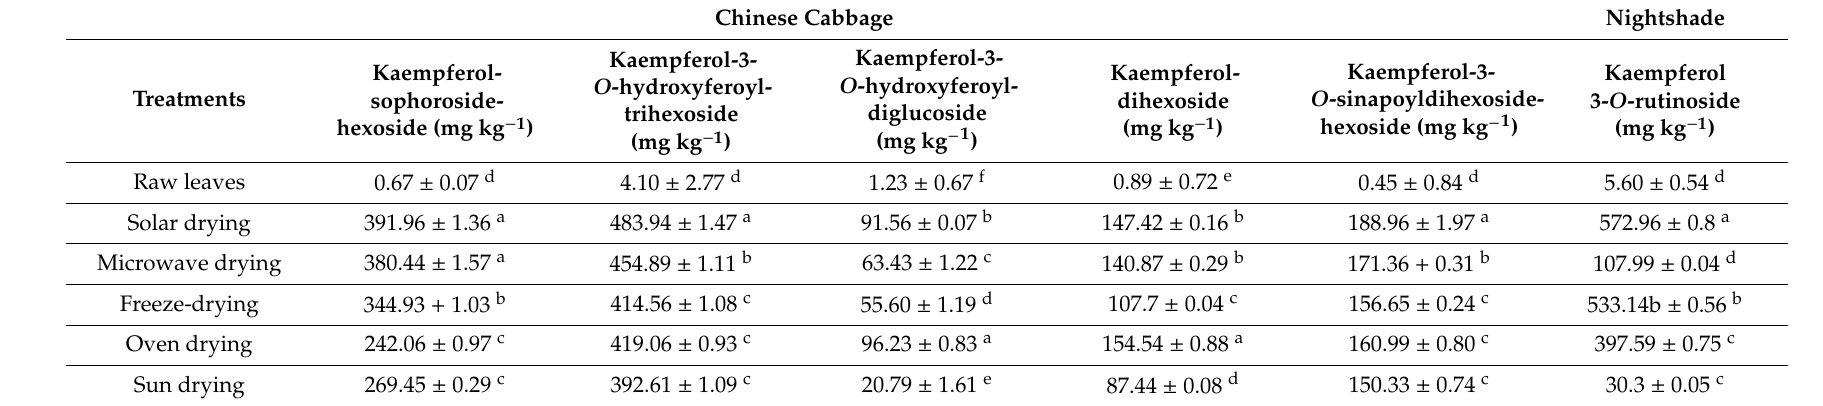
Table 4. Influence of drying treatments on kaempferol derivatives in Chinese cabbage and Nightshade